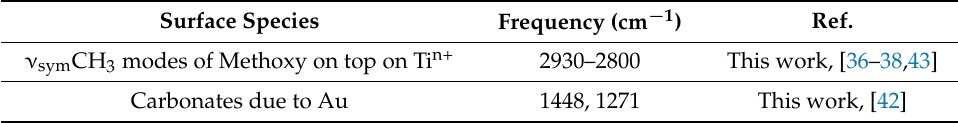
Table 2. IR main bands assignment for Au/TiO 2 Samples.